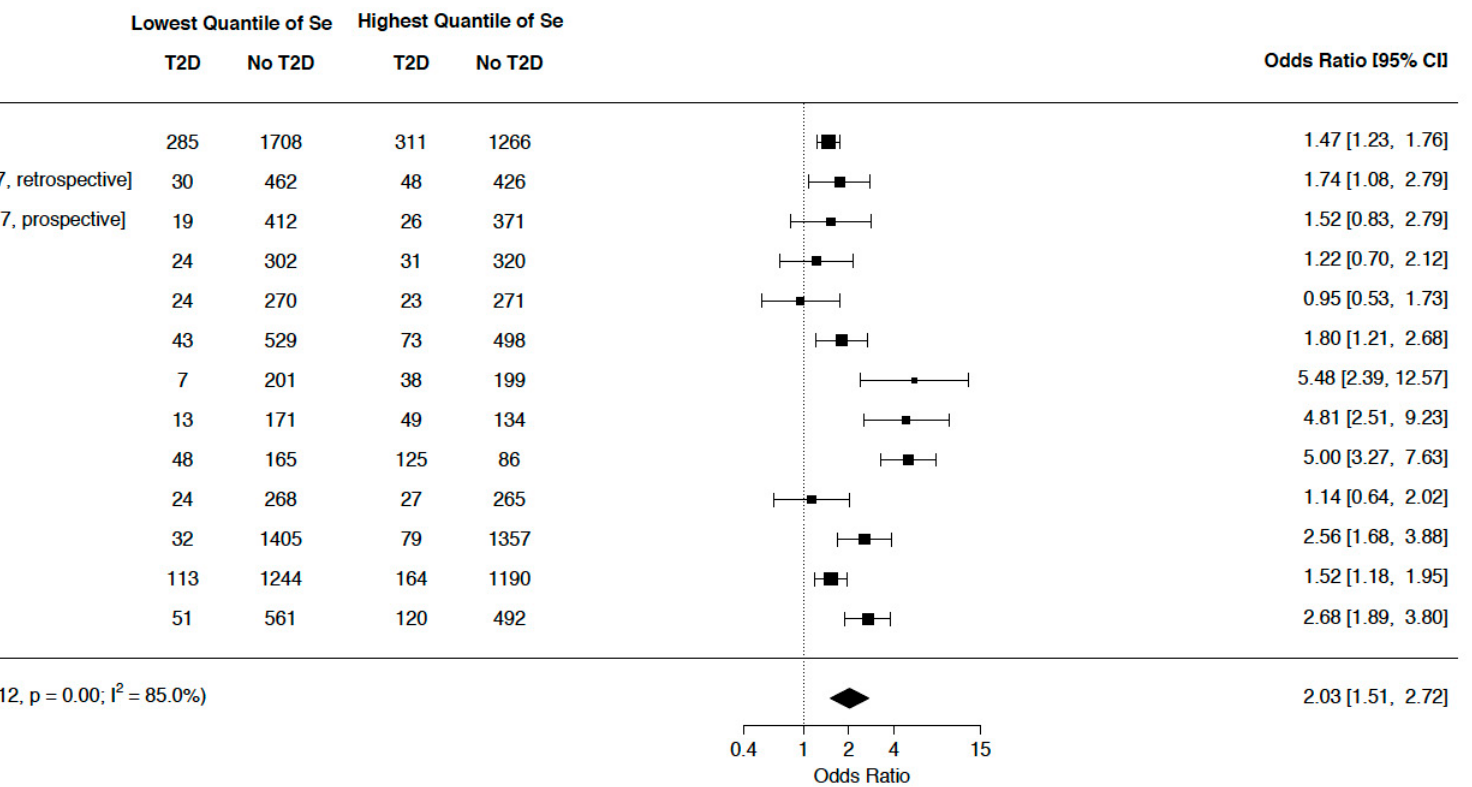
Figure 2. Odds ratios (95% CIs) and summary statistics for the observational studies.